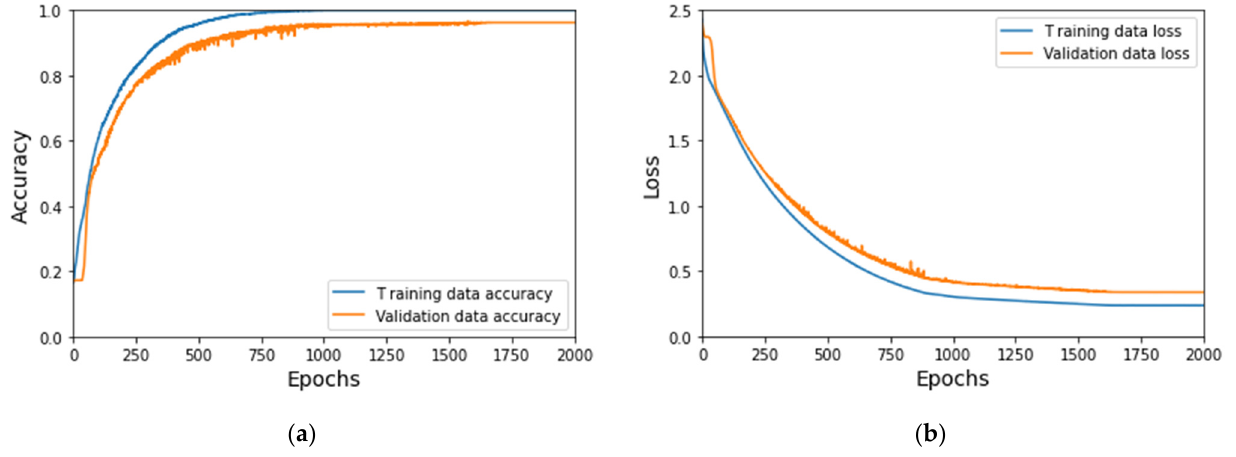
Figure 6. ( a ) Accuracy of training and validation data. ( b ) Loss of training and validation data.